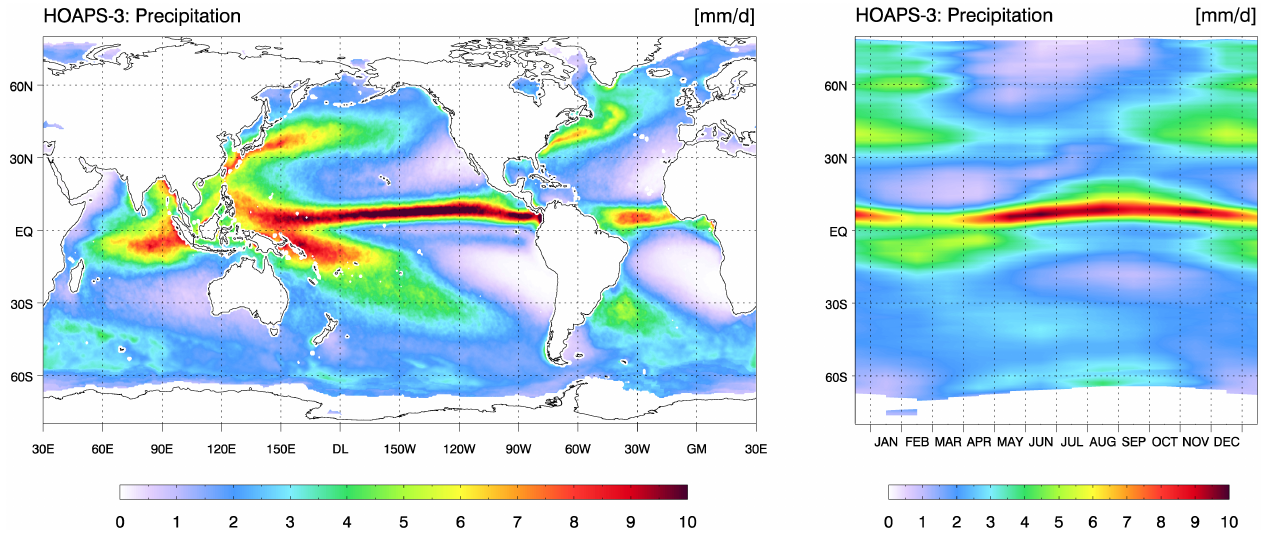
Figure 15. Climatological mean field (left) and zonal mean annual cycle (right) of HOAPS-3 precipitation for the years 1988 to